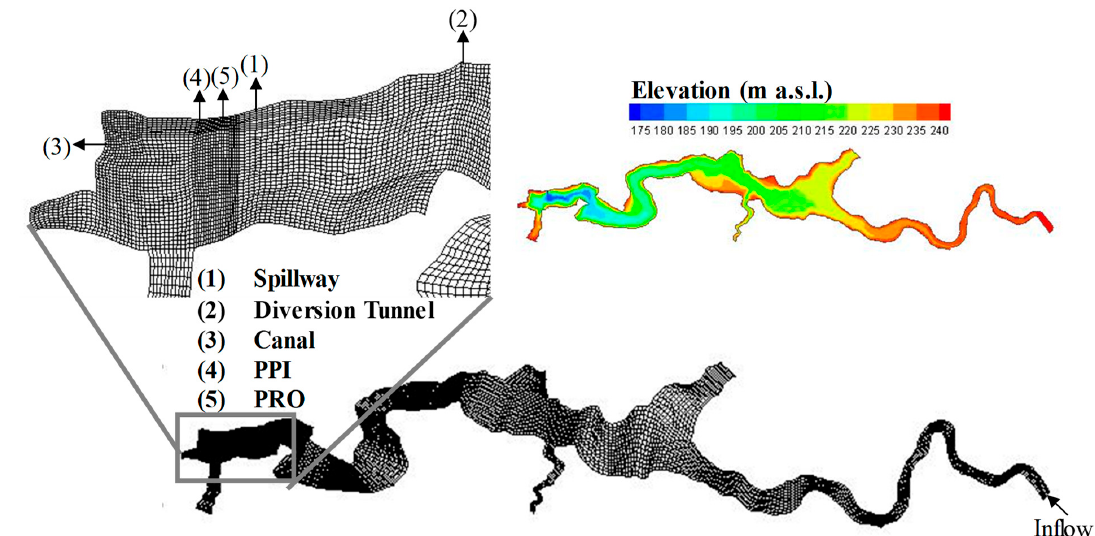
Figure 4. Calculation grid of Shimen Reservoir.